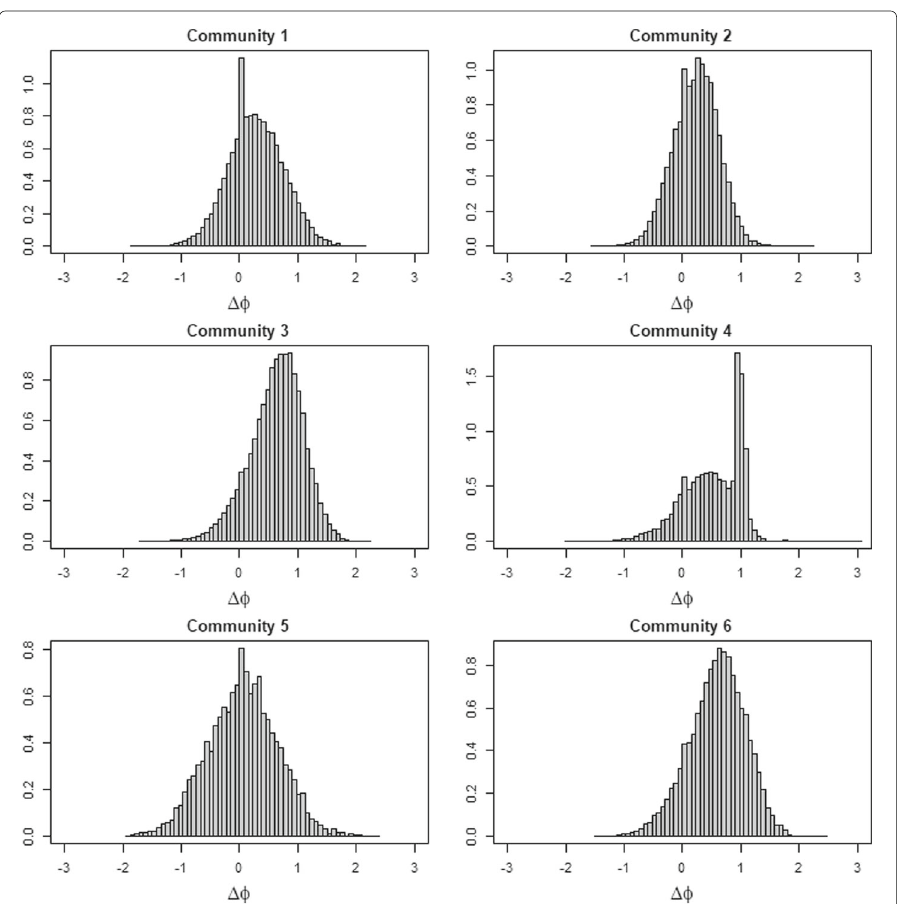
Fig. 11 The 10 largest communities in the circular flow network on the GSCC of the transaction network, visualized in three-dimensional space with three different points of view. The same configuration of firms is used as in Fig. 6.